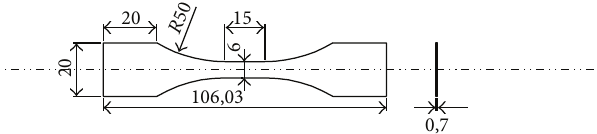
Figure 2: Sample dimensions for tensile fatigue test pieces.